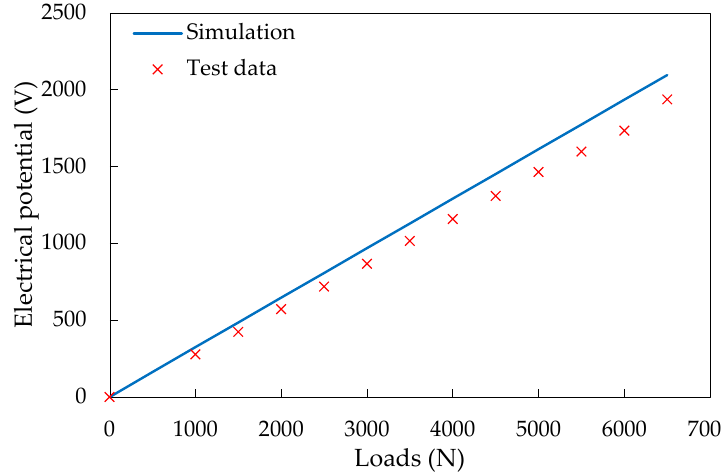
Figure 5. Validation of the piezoelectric unit simulation.